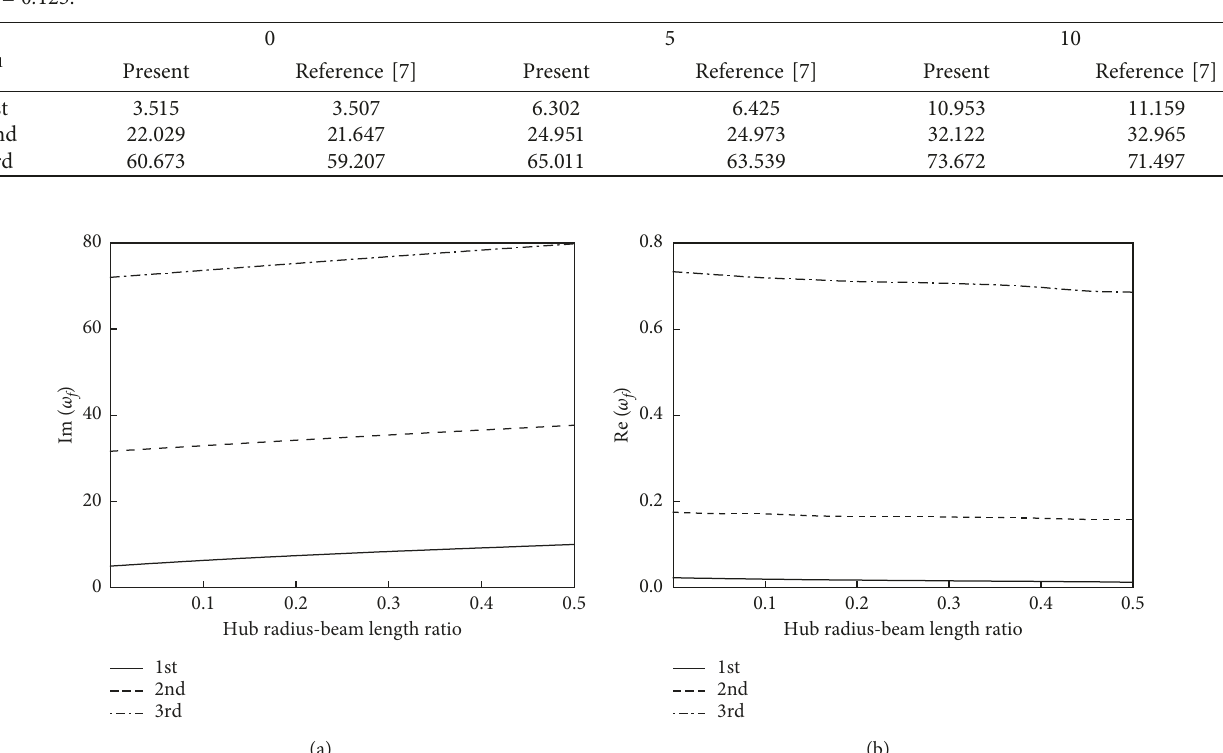
Figure 3: Variation curves of complex frequency of the system with the hub radius-beam length ratio at r � 1/30, g � 0 . 025, ω α � 1/2.